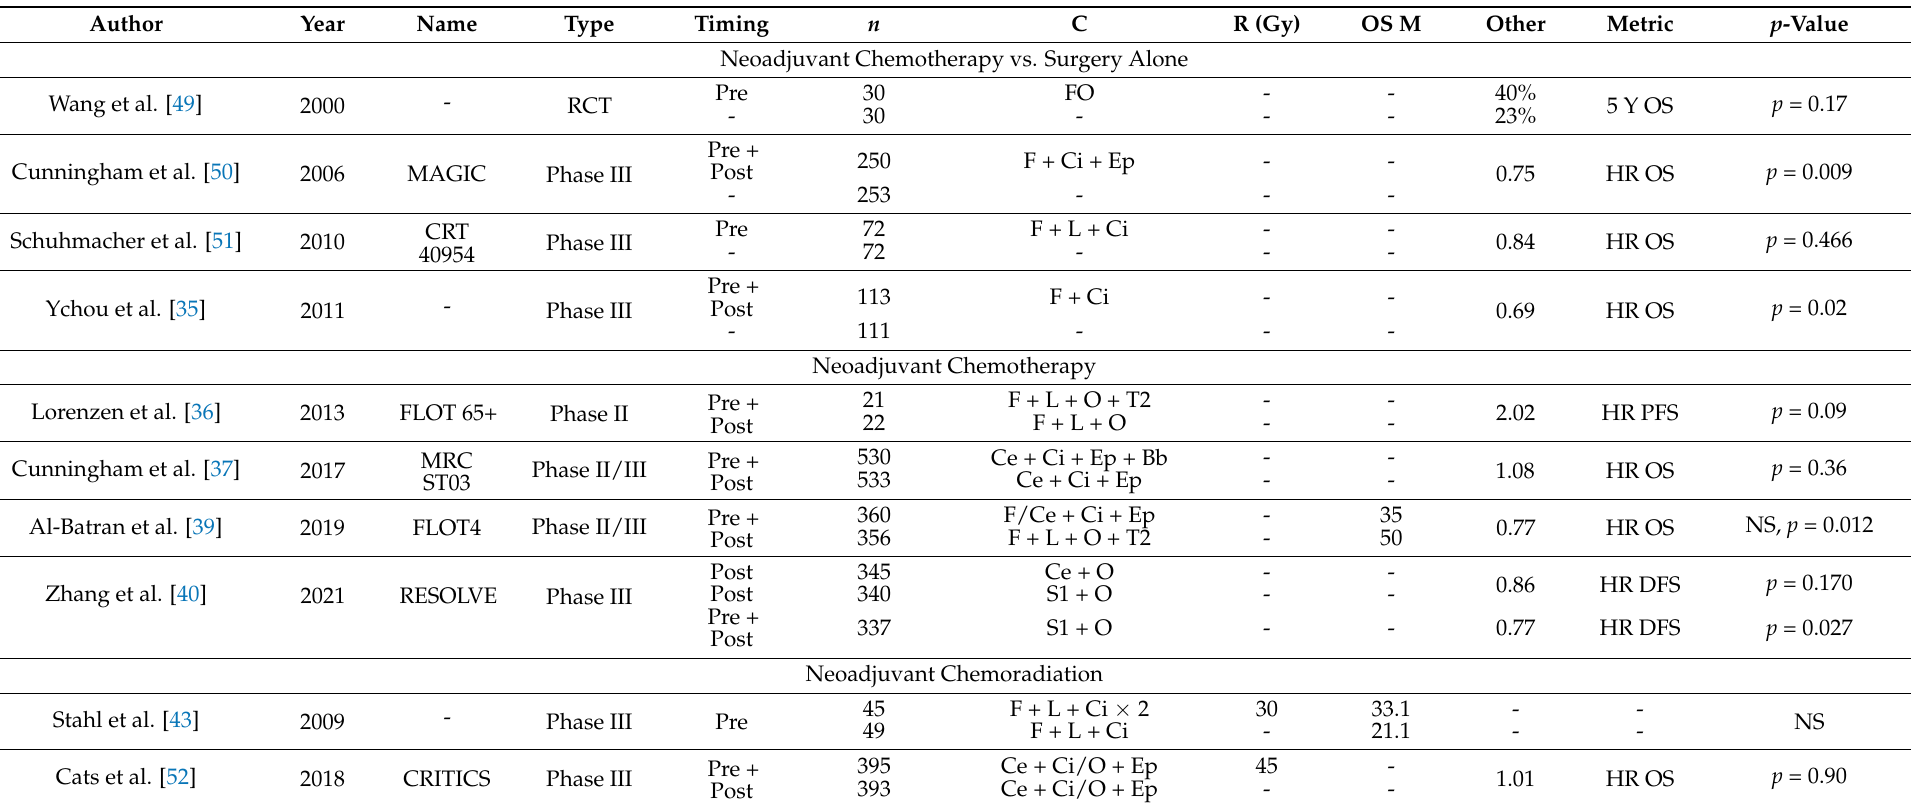
Table 4. Randomized Controlled Trials (RCTs) Evaluating Gastric Adenocarcinoma